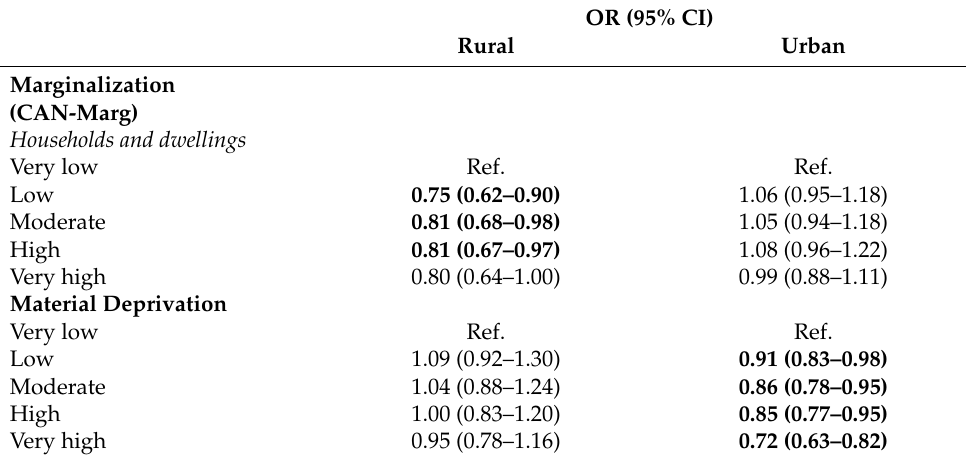
Table 3. Associations between meeting recommendations for fruit and vegetable consumption and neighbourhood environment stratified by